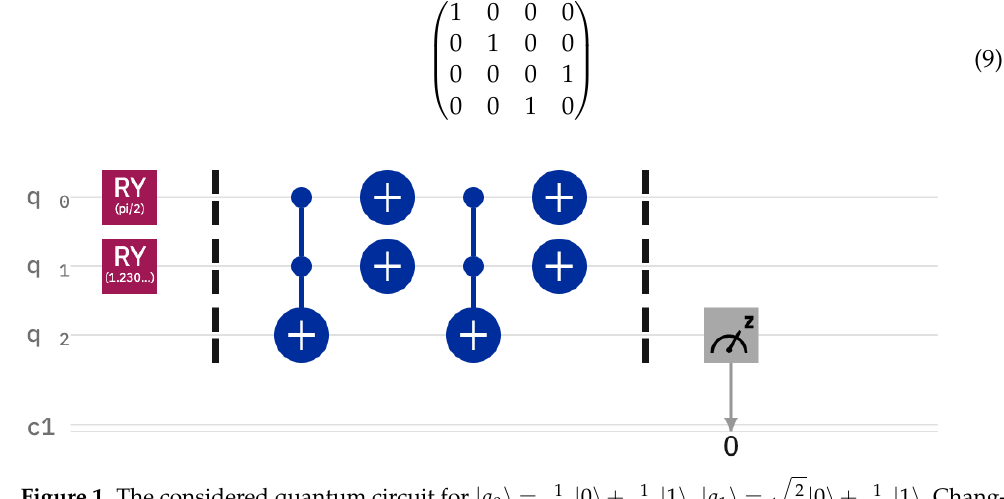
(cid:113) 2 (cid:105) = | 0 (cid:105) + 1 √ | 1 (cid:105) . Chang- | 0 (cid:105) + 1 √ | 1 (cid:105) , | q 1 3 3 2 2